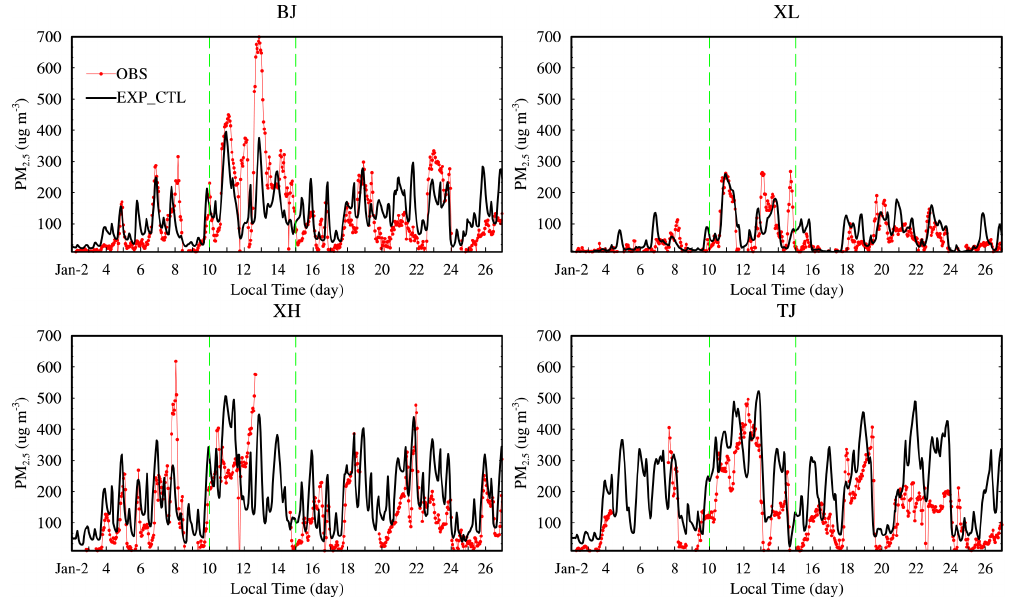
Figure 3. Time series of hourly surface PM 2 . 5 concentration (µgm − 3 ) from the CARE-China network measurement and the corresponding WRF-Chem simulation (EXP_CTL) at BJ, XL, XH, and TJ during 2–26 January 2013.